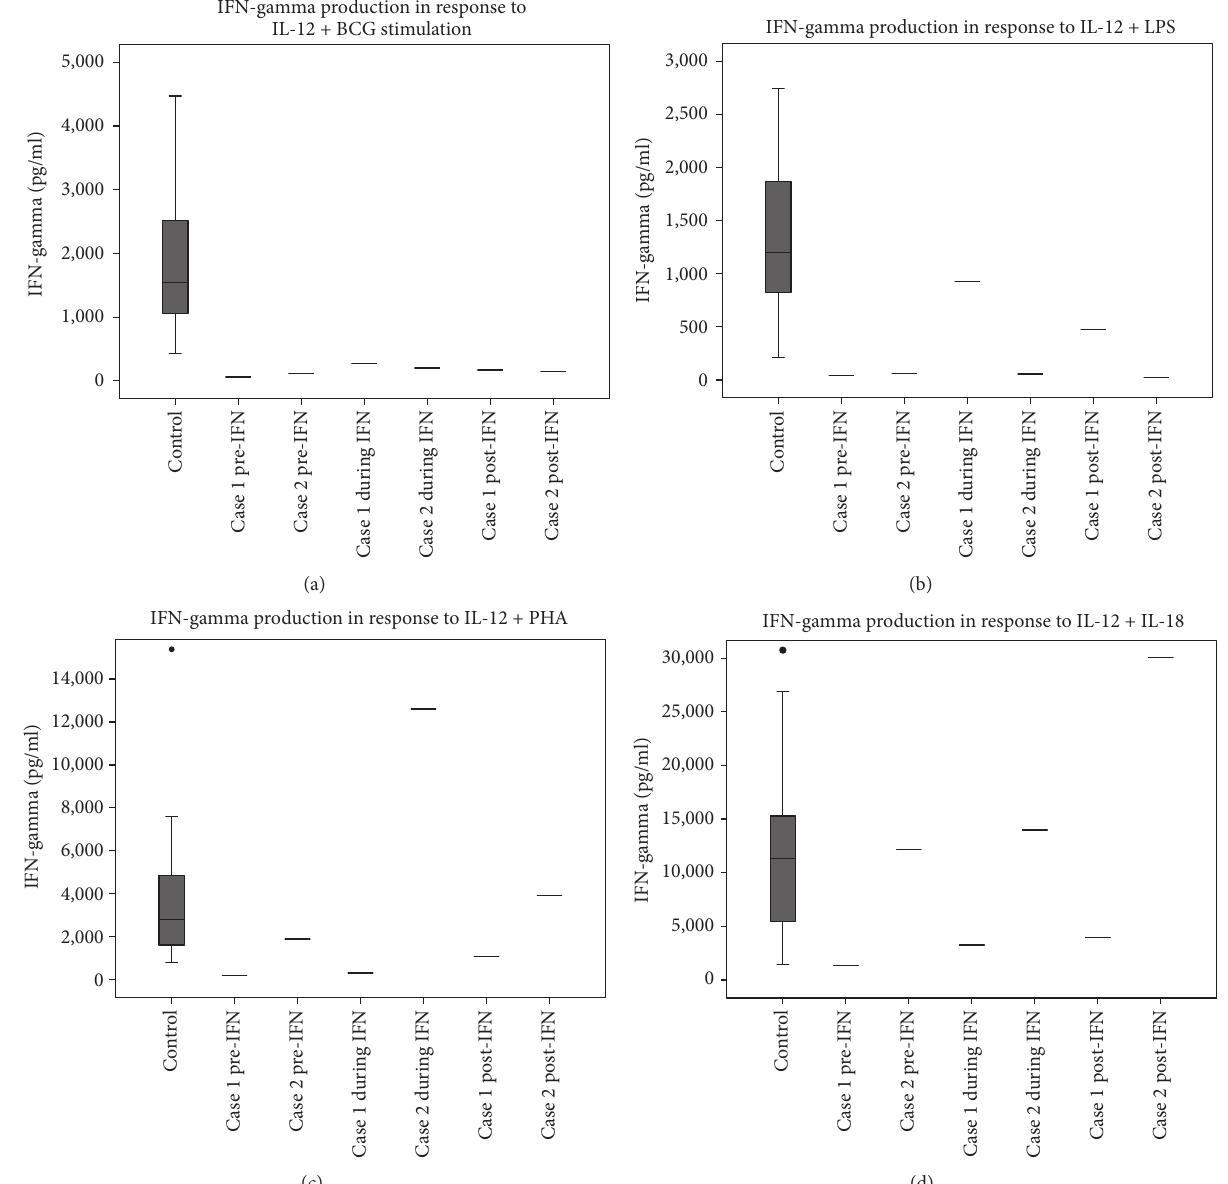
Figure 1: Box plots of whole blood IFN- 𝛾 production to stimulation with IL-12 ± BCG, ± phytohaemagglutinin, and ± IL-18, ± lipopolysaccharide. Whole blood was incubated with stimuli for 16 hours before supernatant was analysed for IFN- 𝛾 . Cases 1 and 2 were sampled at different time points: before commencing IFN- 𝛾 (pre-IFN), 3 months into IFN- 𝛾 therapy (during IFN), and 6 months after stoppingIFN- 𝛾 therapy(post-IFN).Controlboxplotshowingmean,interquartilerange,and1standarddeviation(whiskers)basedonanalysis of 27 healthy controls aged 20–60 yrs. Cases did not have detectable IFN- 𝛾 in the absence of stimuli (Supplementary Figure 1).